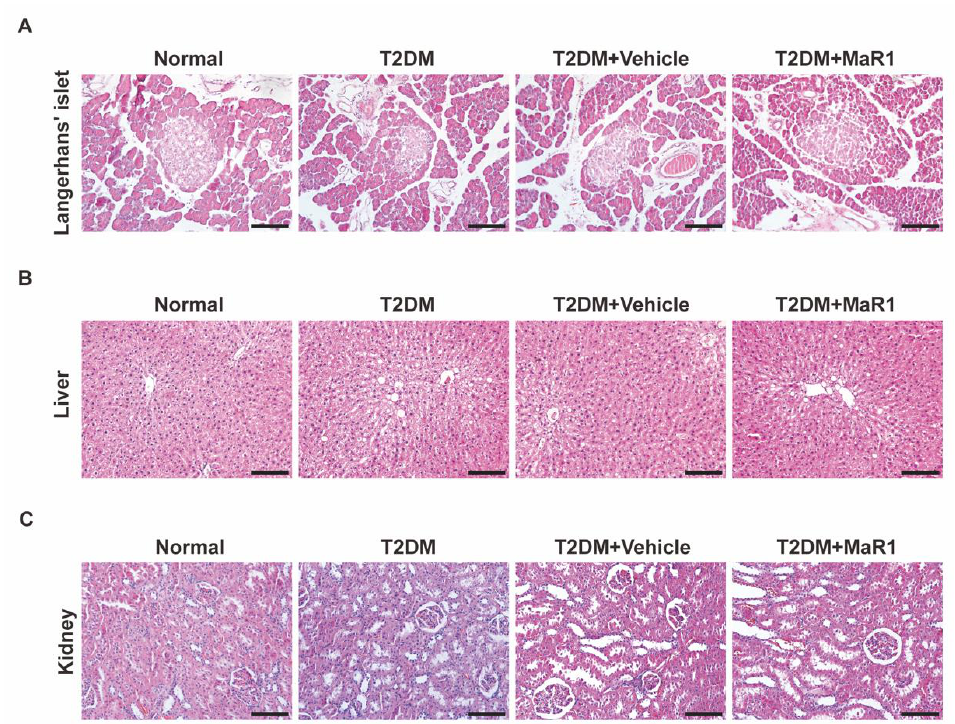
Figure A7. Evaluation of rat pancreases, livers, and kidneys in in vivo experiments. ( A ) The established type 2 diabetes rat model did not cause obvious damage to the islet β cells of the pancreas, and the pancreas shape was still regular compared with the Normal group. Scale bar = 100 μm. ( B ) A small amount of steatosis occurred in the liver cells of the T2DM rats, and the liver cells of the T2DM + MaR1 group showed no obvious pathological changes, such as cell edema and nuclear atypia, suggesting that MaR1 did not cause toxic damage to the rats’ livers. Scale bar = 100 μm. ( C ) The mesangial area of the T2DM rats was widened, the glomeruli were enlarged and swollen, and the tubular vacuoles degenerated. There was no significant difference in renal pathological changes between the T2DM + MaR1 group, the T2DM group, and the T2DM + Vehicle group. Scale bar = 100 μm.